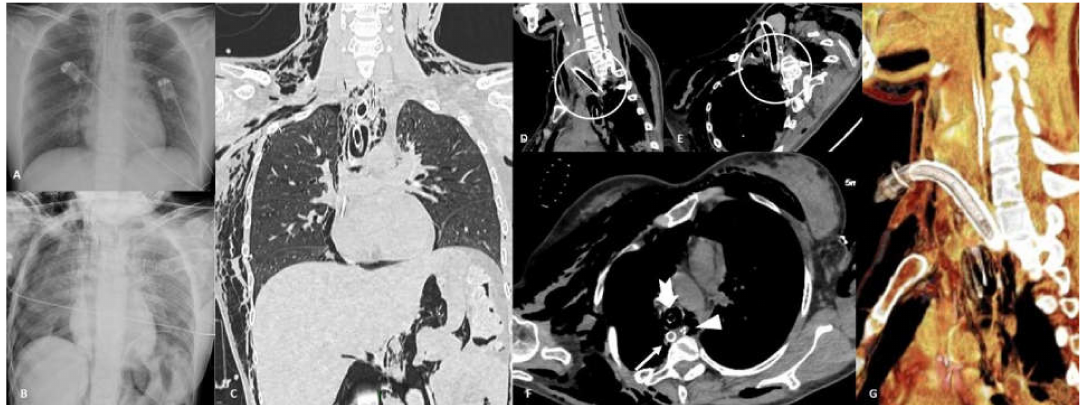
Figure 9. Perforation. Thirty-six-year-old female affected by acute leukemia who underwent tracheostomy placement. Frontal chest radiograph before ( A ) and after ( B ) tracheostomy procedure show the development of right pneumothorax, pneumomediastinum, pneumoperitoneum, and soft tissue emphysema onset. Coronal non-contrast CT scan in lung window ( C ) confirms all these findings. CT unenhanced multiplanar reconstructions ( D , E ) show posterior tracheal wall perforation induced by the tip of the tracheostomy tube; CT axial image ( F ) shows displacement of tracheostomy tip in the posterior mediastinum/prevertebral soft tissue (arrow), correct position of nasogastric tube (NSG) in esophageal lumen (arrowhead), and endotracheal tube correctly cuffed (notched arrow). CT 3D-reconstruction ( G ) better shows tracheostomy tube malposition.